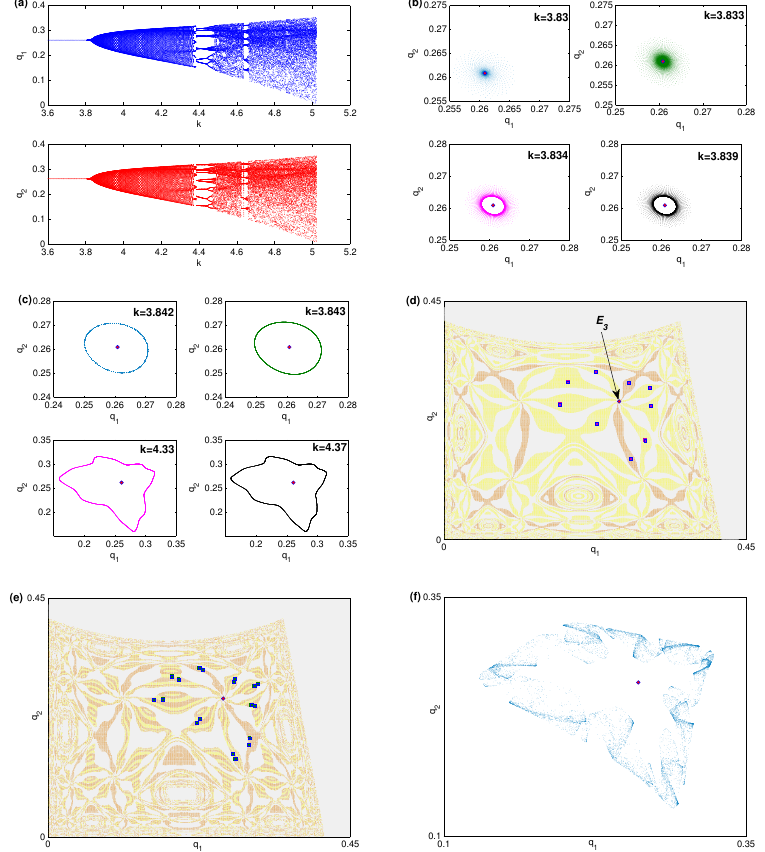
Figure 1. ( a ) Neimark-Sacker bifurcation on varying k . ( b , c ) Different dynamical situations at different values of k . ( d ) The basin of attraction of the period-9 cycle at k = 4.4. ( e ) The basin of attraction of the period-18 cycle at k = 4.45. ( f ) Chaotic attractor at k = 4.50. The other parameters’ values are, a = 0.7, b = 0.3 and c = 0.1 with the initial datum ( q 1 , q 2 ) = ( 0.11,0.12 )